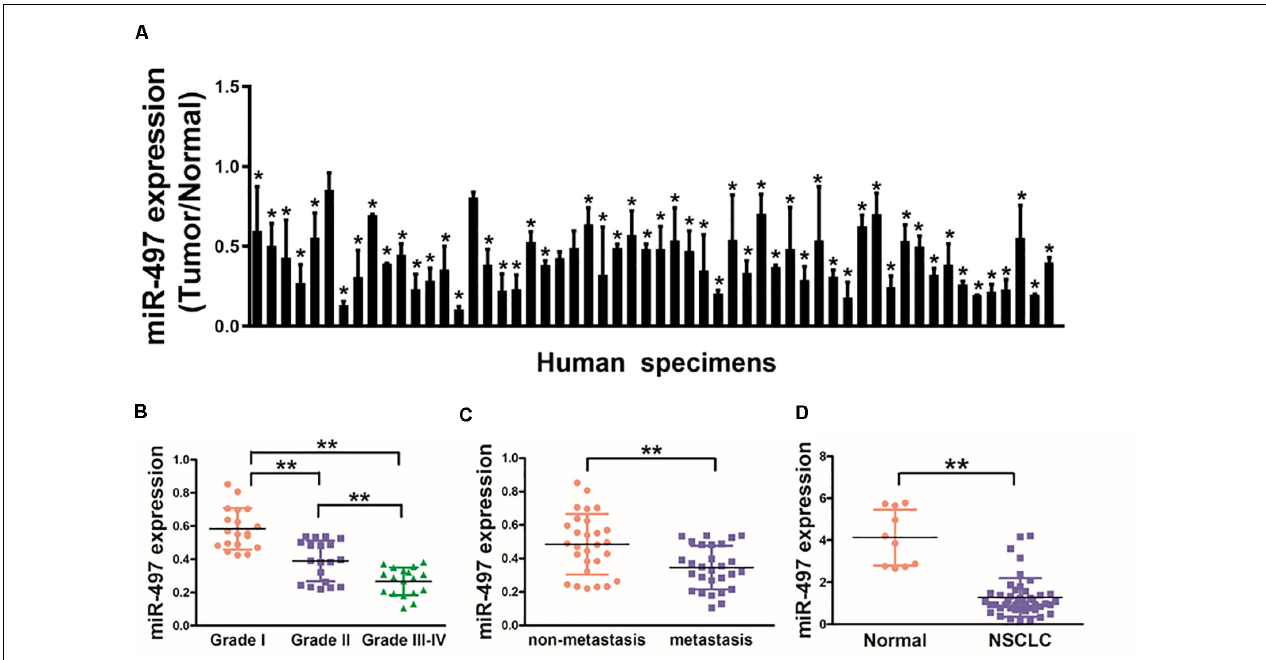
FIGURE 1 | Down-regulation of miR-497 expression in tumor tissues of human lung cancer patients. (A) Expression levels of miR-497 in 56 pairs of lung cancer tumor and adjacent normal specimens were analyzed by stem-loop qRT-PCR, and normalized to the levels of U6. The fold changes were obtained by the ratio of miR-497 abundance in cancer tissues to that in the adjacent normal tissues. (B) Relative expression levels of miR-497 in different stages of cancer tissues. (C) qRT-PCR analysis of miR-497 expression in 56 pairs of primary NSCLC tissues and their corresponding lymph node metastases. (D) miR-497 expression was decreased in plasma of NSCLC patients. The relative expression levels of miR-497 were detected and normalized to the spiked-in control cel-miR-39 (spiked-in control). Data were presented by mean ± SD. of 3 replicates. *indicated P < 0.05, ** indicated P < 0.01.